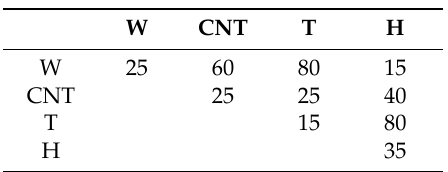
Table 4. All repulsion parameters for water (W), CNT, and SDS beads in k B T units. H and T represent head and tail beads of SDS